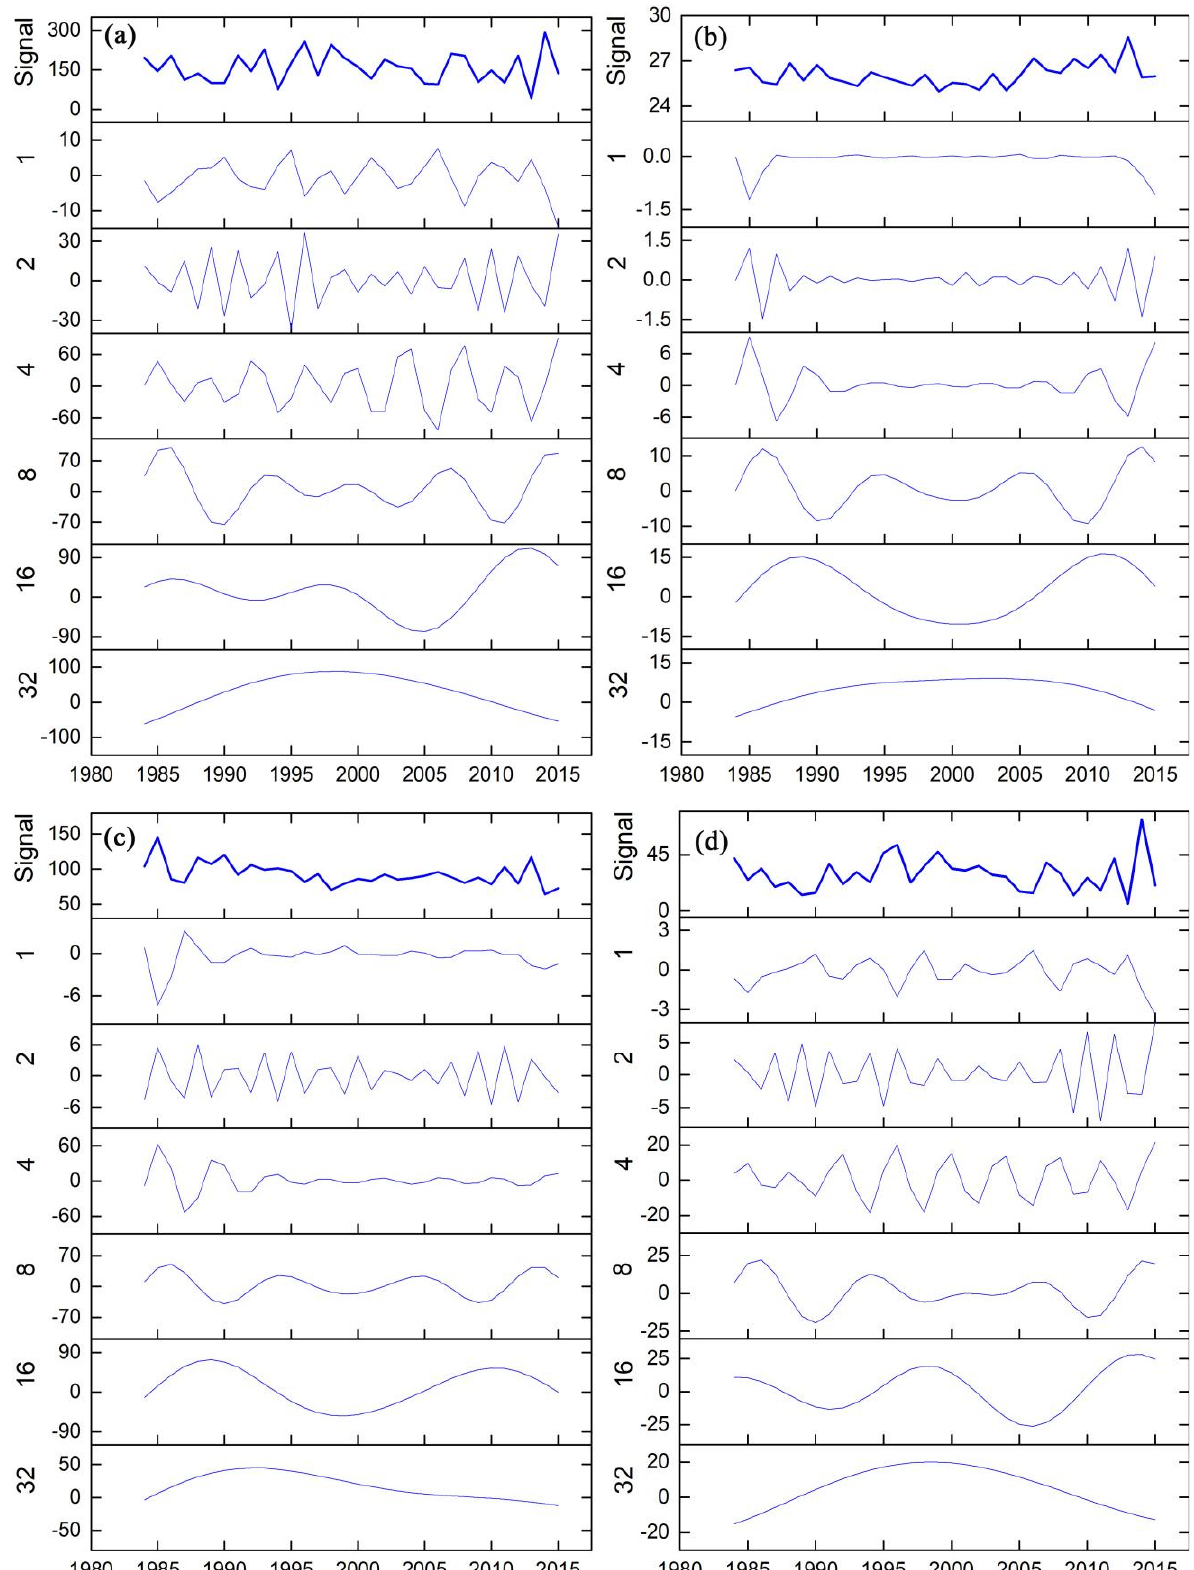
Figure 4. Multi-time-scale variations of rainfall ( a ), temperature ( b ), evaporation ( c ) and runoff ( d ) in spring.